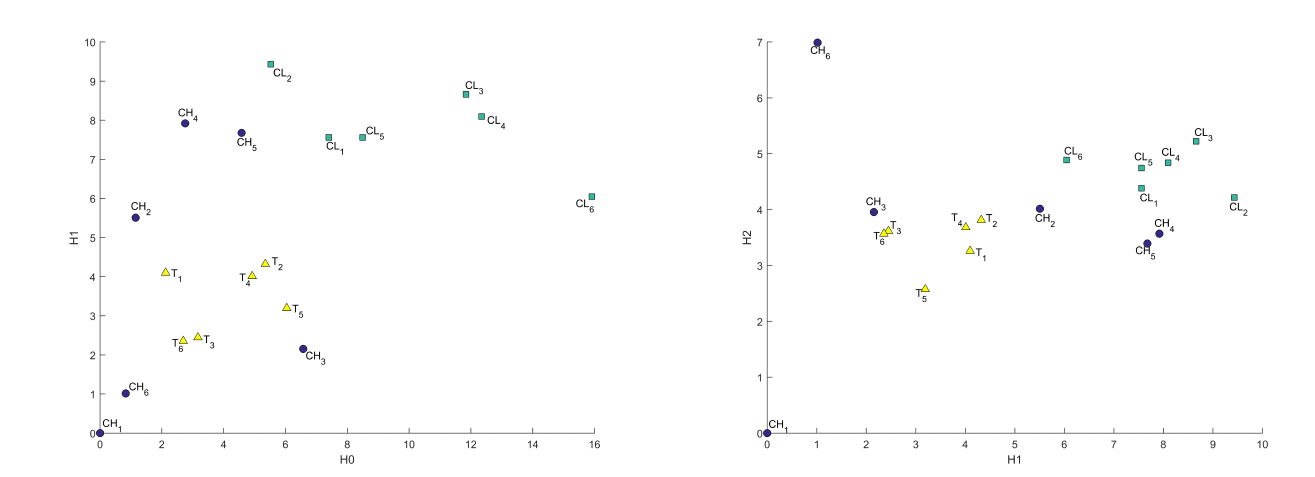
Figure 13. Comparison of 2 classes of C ( CH, CL ) samples with T samples ( T ) in Bottleneck metric in H 0 – H 1 and H 1 – H 2